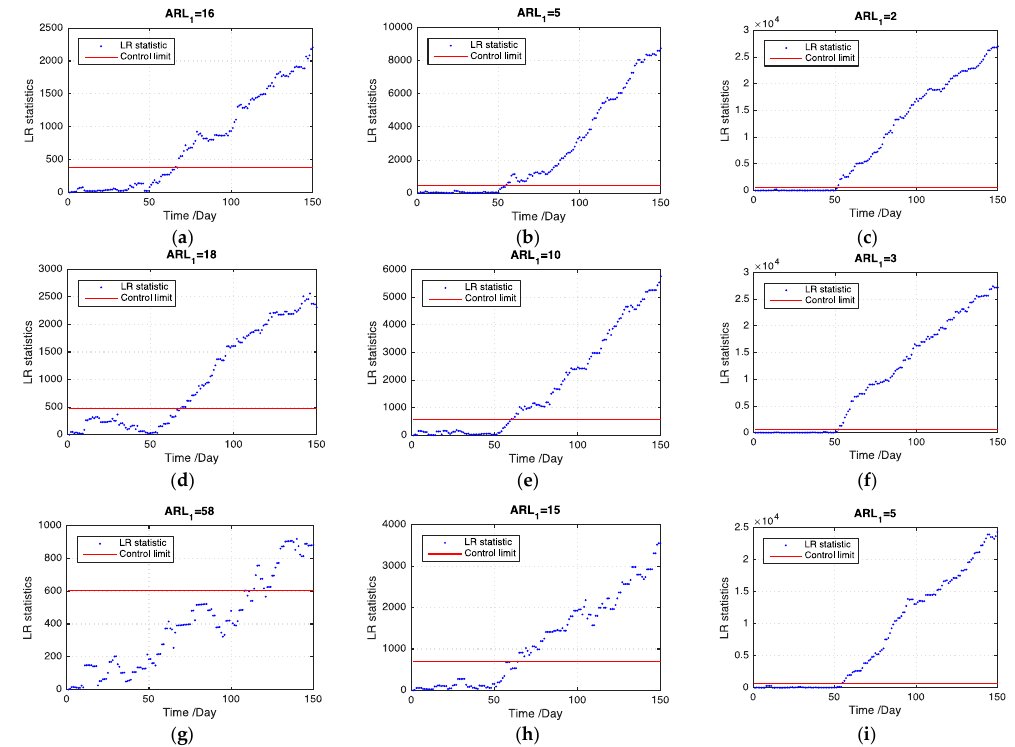
Figure 5. LR statistics using the proposed model for detecting the medium outbreak cluster. (Note: the ranges of the Y -axis in each graph are substantially different.). ( a ) shift magnitude = 0.5, 20% missing values; ( b ) shift magnitude = 1, 20% missing values; ( c ) shift magnitude = 2, 20% missing values; ( d ) shift magnitude = 0.5, 30% missing values; ( e ) shift magnitude = 1, 30% missing values; ( f ) shift magnitude = 2, 30% missing values; ( g ) shift magnitude = 0.5, 50% missing values; ( h ) shift magnitude = 1, 50% missing values; ( i ) shift magnitude = 2, 50% missing values.